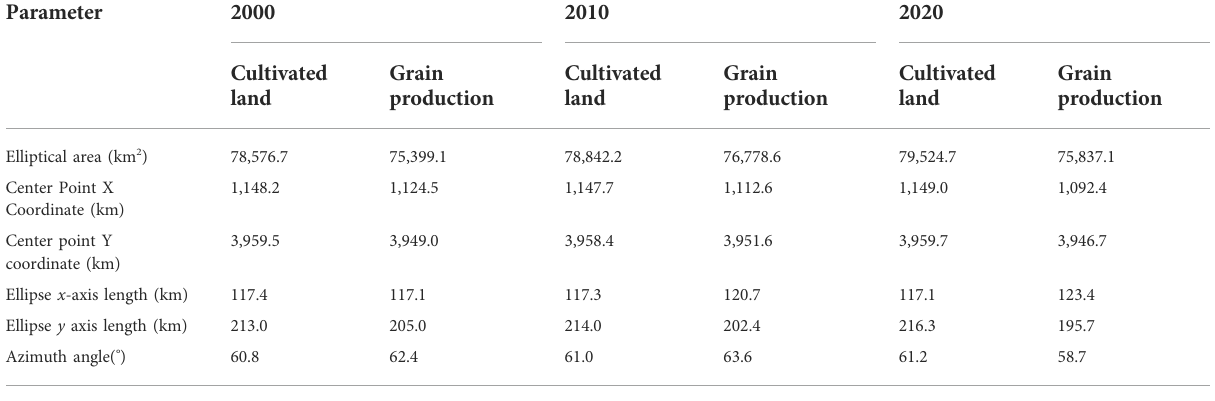
TABLE 5 Standard deviation ellipse model of cultivated land and grain